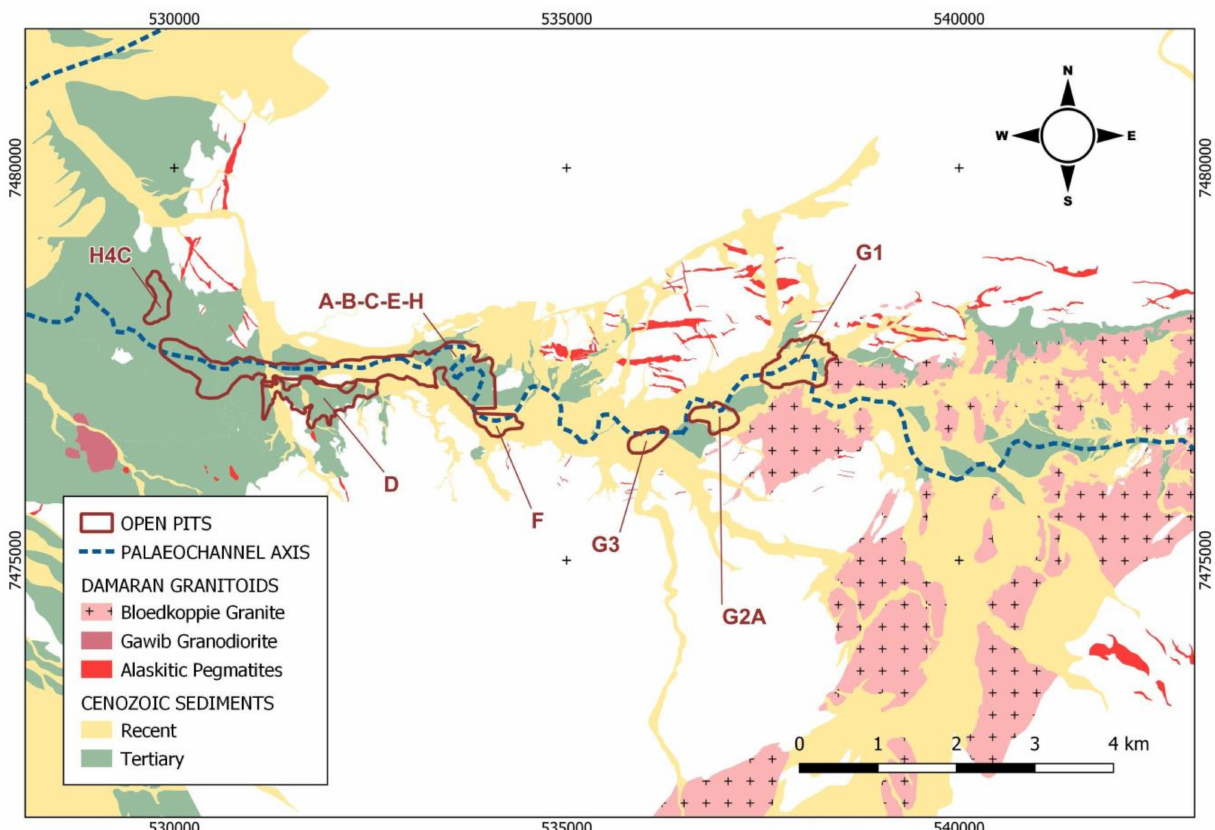
Figure 6. Simplified geological map of the Langer Heinrich area (after [21]). Recent sediments are related to the present day Gawib ephemeral drainage (see Figure 3A). White areas are outcropping Damaran metamorphic rocks, notably the schist of the Tinkas Formation. Letters refer to open pit